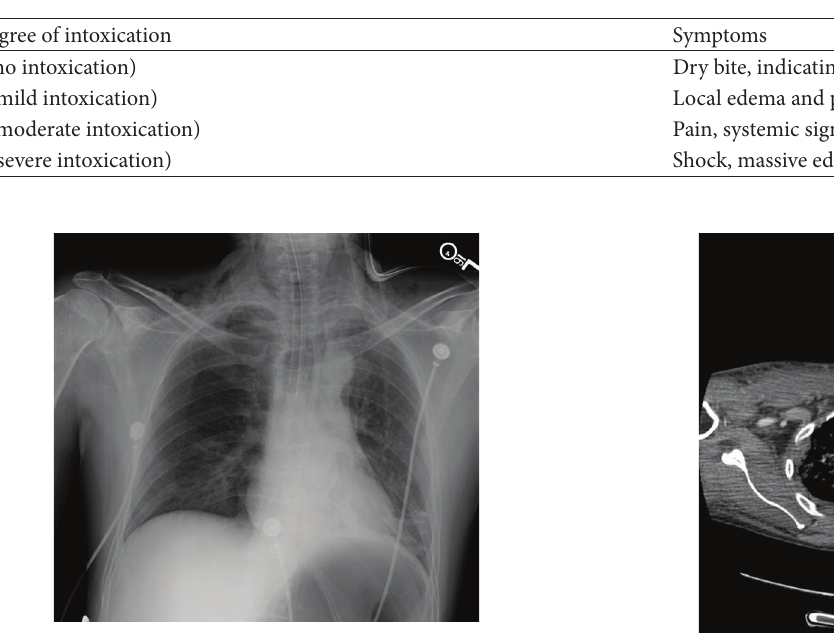
Table 1: Degree of intoxication due to envenomation.